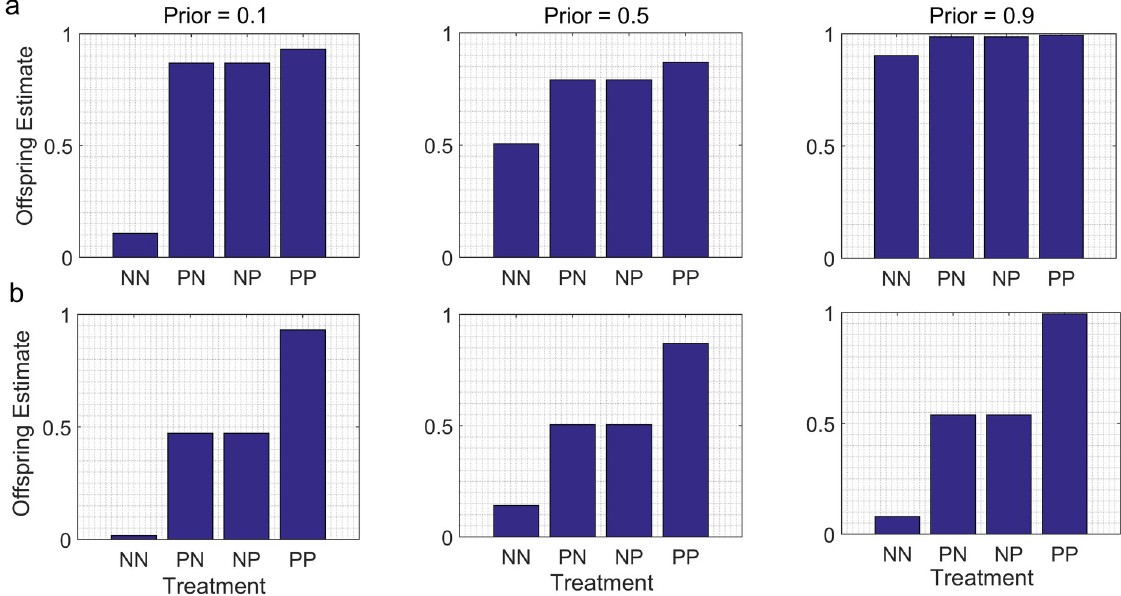
Fig 1. How differences in the reliability of the cues in the different treatments affect offspring estimates of the value of conditions in the external environment. P treatment = exposure to cues from a predator, N treatment = no cues from predator, first letter = parental treatment, second letter = offspring treatment. Predicted offspring estimates at the end of an experiment for each of four treatment groups (NN, PN, NP and PP) are indicated for parental Priors with three different means (0.1, 0.5, 0.9) and the same variance (0.04). a. N- models: conditions in the N treatment provide much less reliable information than conditions in the P treatment. In this example, information provided by conditions in the P treatment is modelled by a cumulative likelihood function with a shape indicated by α = 8, β = 1, indicating that the value of the state is likely to be high; information provided by conditions in the N treatment is modelled by a uniform distribution ( α = 1, β = 1). b. N � models. Conditions in the N treatment provide information as reliable as conditions in the P treatment; the likelihood functions for the P and N treatments are mirror-images of one another. In this example, conditions in the P treatment indicate with a high level of reliability that the state of the environment is likely to be high (likelihood modelled by α = 8, β = 1); conditions in the N treatment indicates with equally high reliability that the state of the environment is likely to be low (likelihood modelled by α = 1, β =